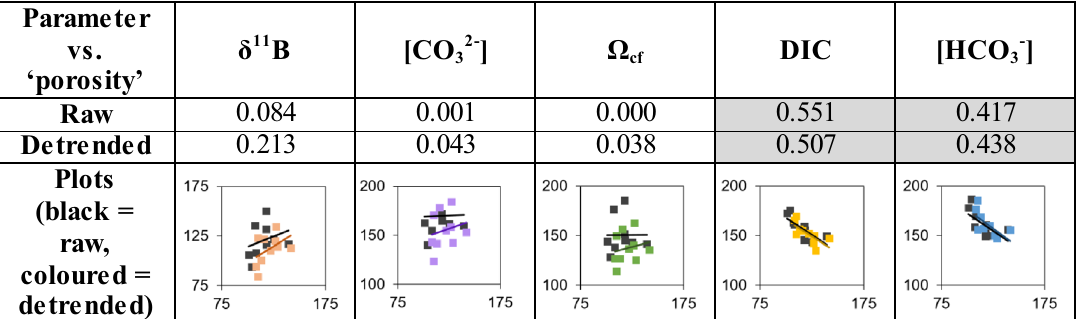
Table 1. Correlation coefficient squared (r 2 ) between ‘grey-scale value’, here a proxy for porosity, δ 11 B, and the reconstructed carbonate system variables as raw data and with linear trends removed. The strongest relationships are with DIC and [HCO 3− ] (and are negative), both in raw and detrended datasets. In the third row of the table are cross-plots with the ‘grey-scale value’ on the x-axis versus the carbonate system parameter on the y-axis. Black squares are raw data and coloured squares are detrended. For further details, see figure S2. The values in grey boxes indicate where the relationship is statistically significant ( p <